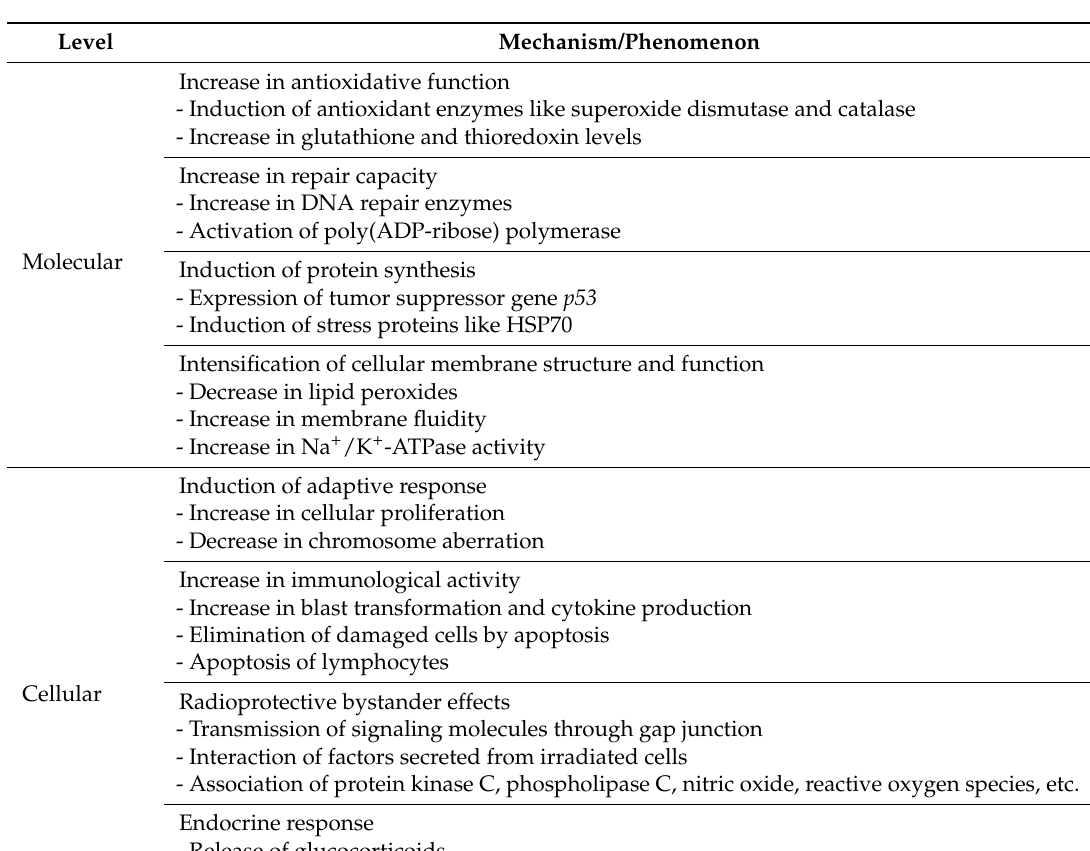
Table 1. Mechanisms and phenomena of radioadaptive response/radiation